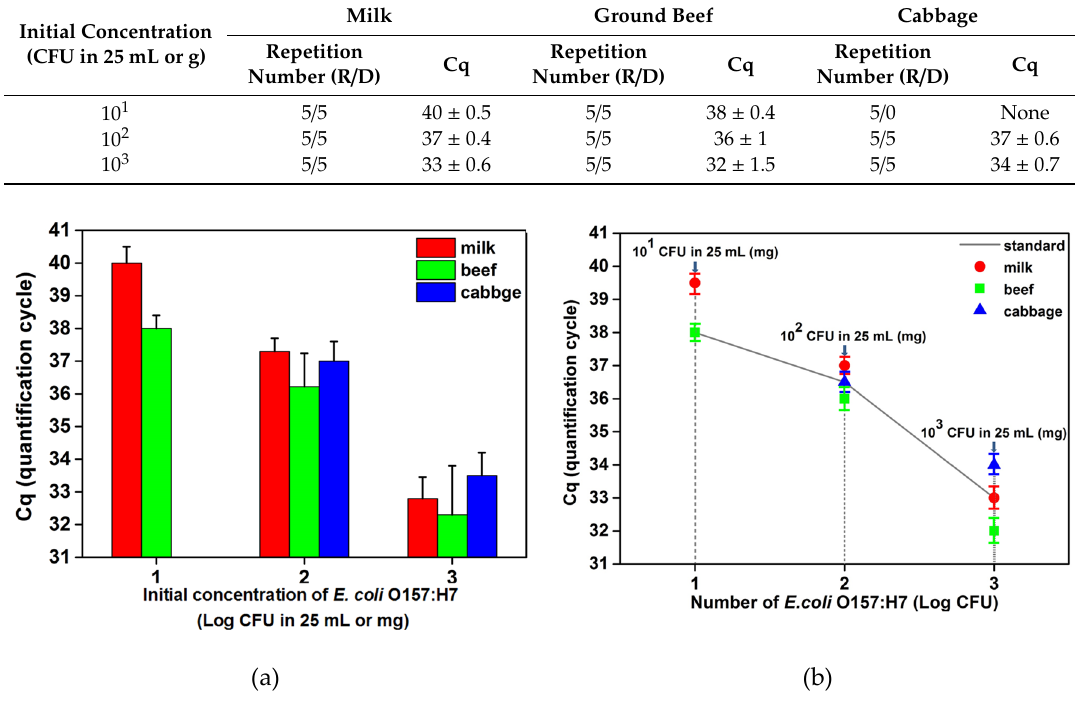
Table 1. Cq analysis with standard deviations and number of repetitions/detections (R/D) of the real- time PCR assay using the samples recovered by the automated IMS process from E. coli O157:H7- contaminated food samples.